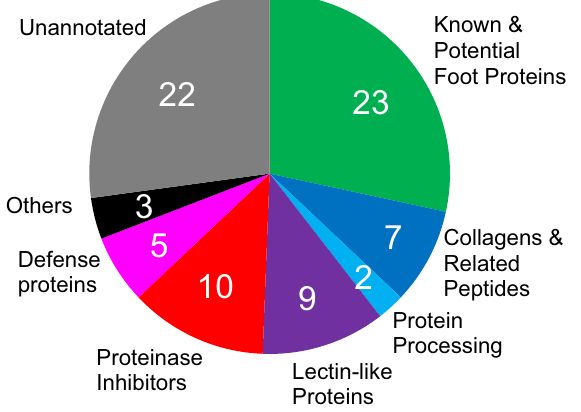
Figure 3. Classification of 81 Highly Expressed genes in the Foot (HEFs) in Perna viridis . Numbers are gene numbers in each